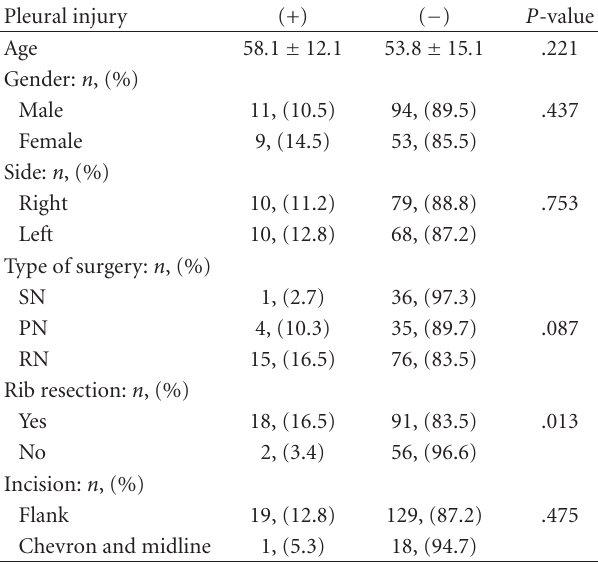
Table 1: Analysis of risk factors for occurrence of pleural injury during